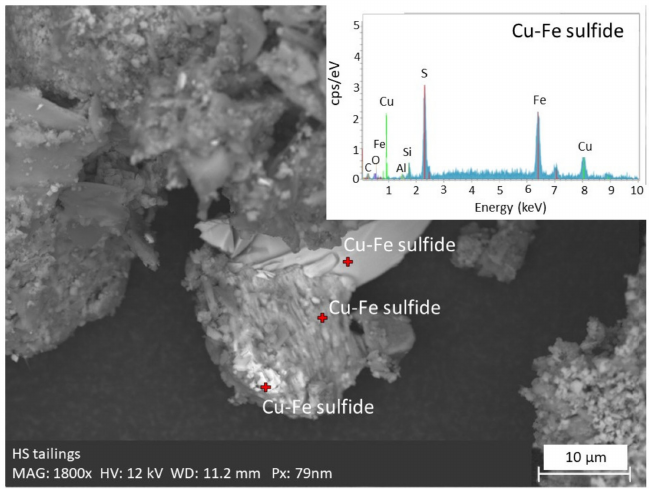
Figure 2. SEM image and EDX spectrum of Cu-Fe sulfide minerals observed in HS tailings.